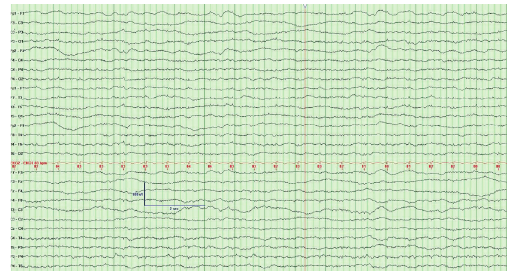
Figure 2: EEG on hospital day 3, showing theta frequency slowing and artifacts from spontaneous horizontal and vertical eye move- ments but no triphasic activity and no epileptiform activity. HFF 70 Hz, LFF 1Hz; sensitivity and time base indicated on image.